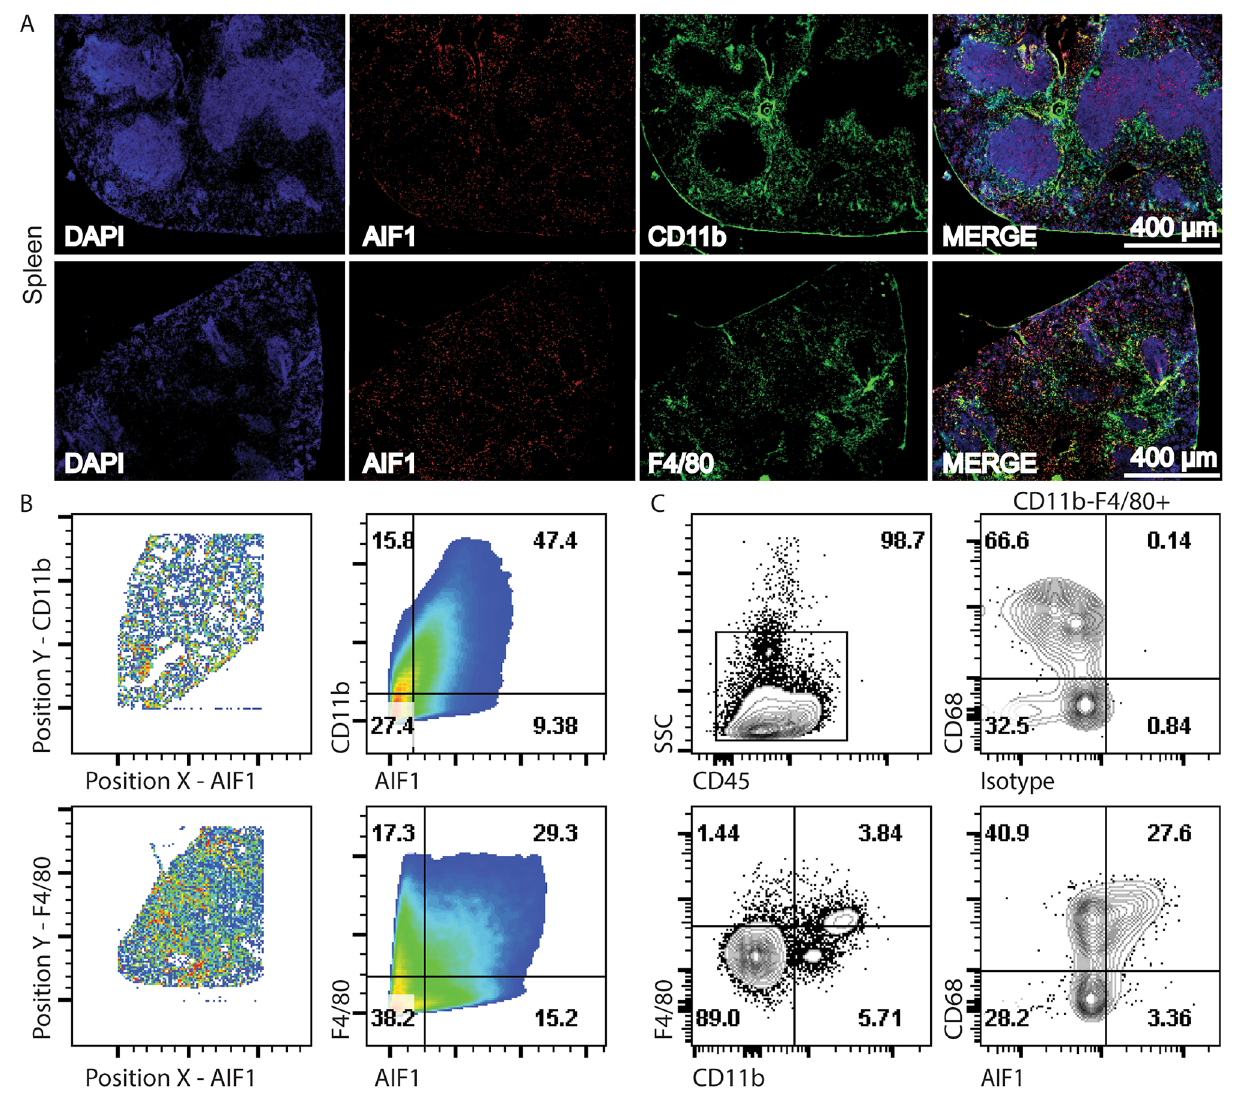
Figure 1. Tissue monocyte-macrophage lineages express AIF1. Spleen sections were prepared from C57BL6 mice ( n = 6) to assess AIF1 expression by fluorescence microscopy and flow cytometry. ( A ) Tissues were cryosectioned at 16 μm and stained with fluorochrome conjugated antibodies to CD11b or F4/80 along with AIF1. DAPI dye was used for nuclear detection. Images were acquired using a standard wild-field fluorescence microscope and presented at 4x magnification. Microscopy data is one representative image of two independent experiments with a total of two mice. Scale bar represents 400 μm. ( B ) Images were further analyzed in FlowJo software for quantitative analyses. Co-localization of intensity of the Y-channel against the X-channel is plotted to determine co-expression of AIF1 with either CD11b or F4/80. ( C ) For flow cytometric analyses, spleen tissues were dissociated and stained with fluorochrome conjugated antibodies to CD11b, CD68, F4/80 and CD45 prior to acquisition. Cells were then analyzed for AIF1 and CD68 expression in CD11b neg F4/80 + subsets. Flow cytometric data is representative of four independent